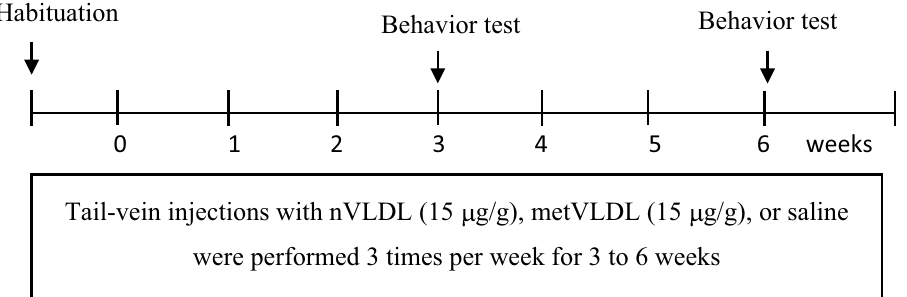
Figure 1. Schematic diagram showing the experimental protocol used for VLDL tail-injection studies in